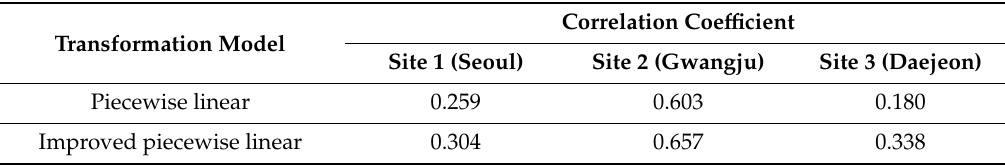
Table 4. Comparative accuracy of PL transformation (real dataset) in the outer triangular